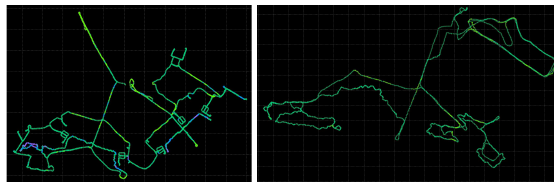
Figure 3. The two acquisition paths that are necessary to cover the whole